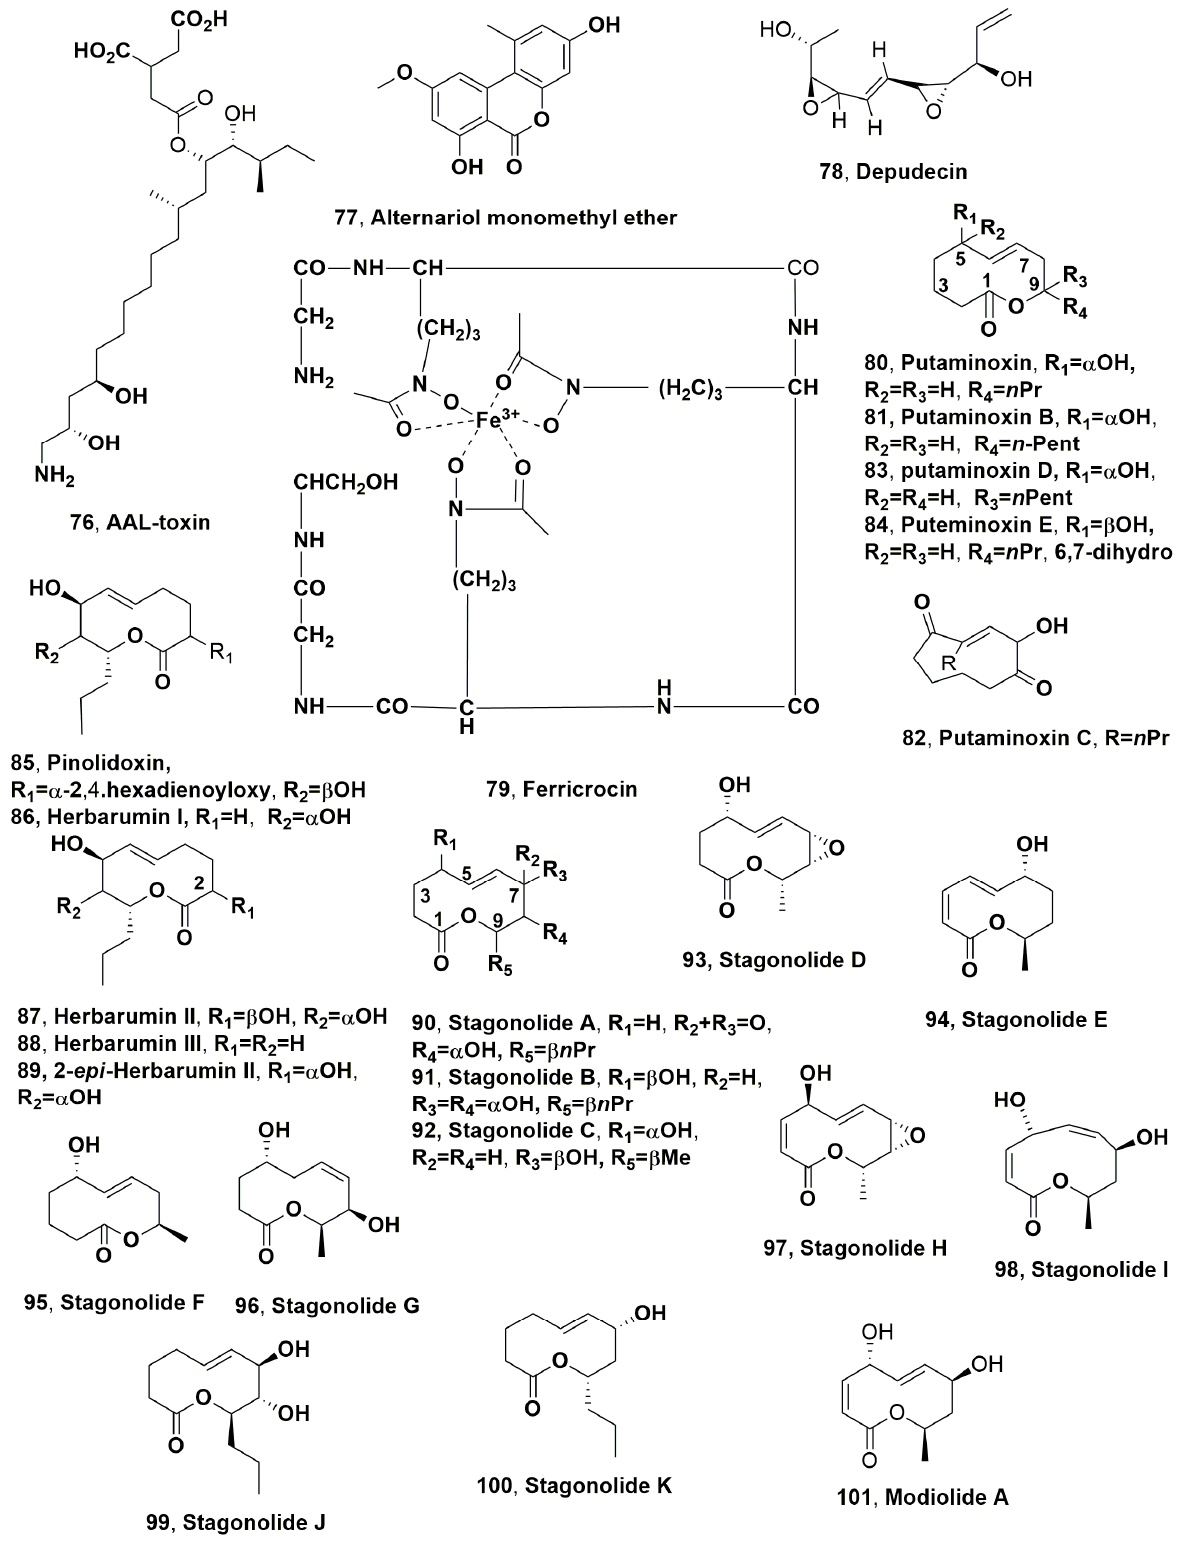
Figure 4. Metabolites produced by Alternaria alternata ( 76 and 77 ), Nimbya scirpicola and Alternaria brassicola ( 78 ), Colletotrichum gloeosporioides ( 79 ), Phoma putaminum ( 80 – 84 ), Dydimella pinodes ( 85 ), Phoma herbarum ( 86 – 89 ) and Stagonospora cirsii ( 90 – 101 ). Ferricrocin ( 79 , Figure 3) is a siderophore which was isolated as phytotoxic metabo- lite from the culture of Colletotrichum gloeosporioides obtained from infected blackberry